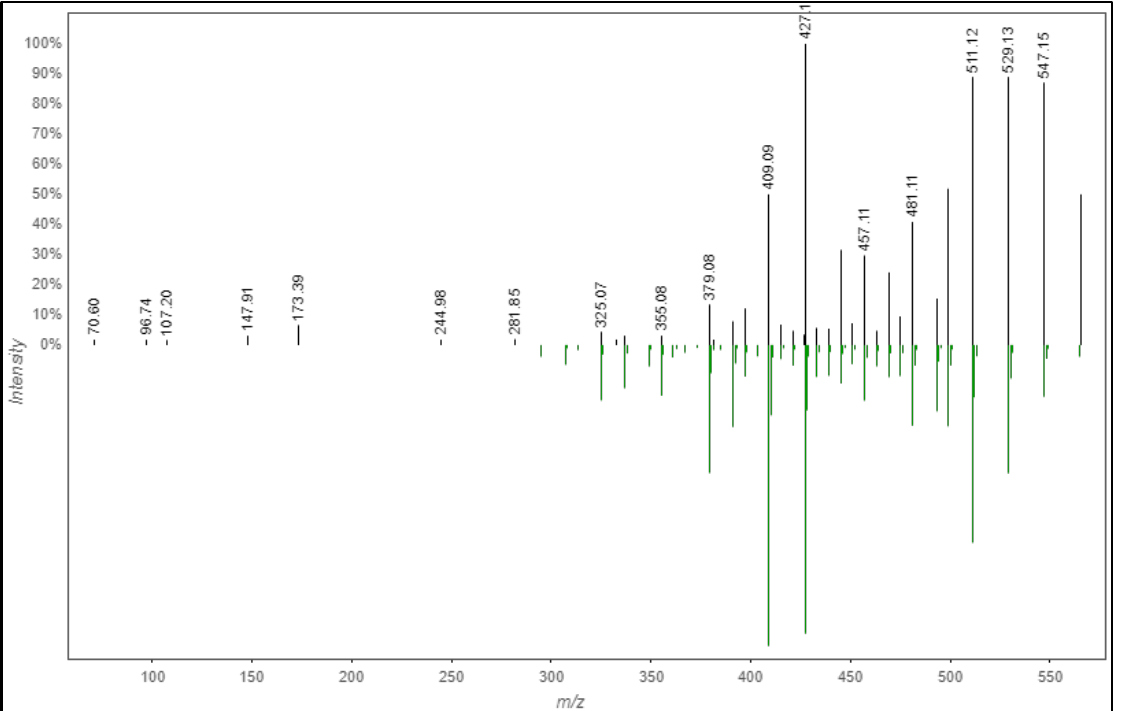
Figure 4. Mirror match of 2 with isoschaftoside with the reference spectra with gold library class and 0.82 cosine value.